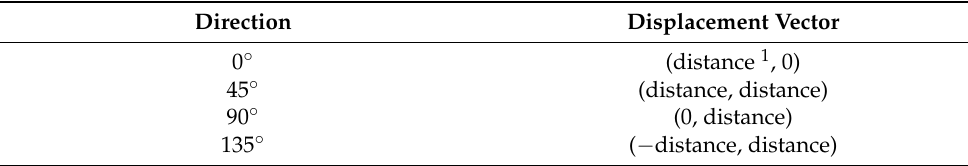
Figure 2. The four independent directions used to compute the 2D GLCM. Table 1. Displacement vectors for 2D